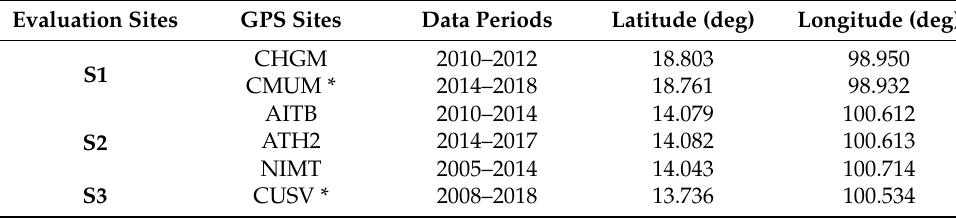
Table 1. Characteristics of Global Positioning System (GPS) sites used in this study. The sites with an asterisk (*) are still in operation. The evaluation sites represent the model grid cell location used in the evaluation process. The measurements from GPS sites inside the same PCRaster Global Water Balance (PCR-GLOBWB) model grid cell are averaged. The averaging process results in three (independent) time series of S1–S3 sites (model grid); see, e.g., Figure 3a for their locations on the map. Evaluation